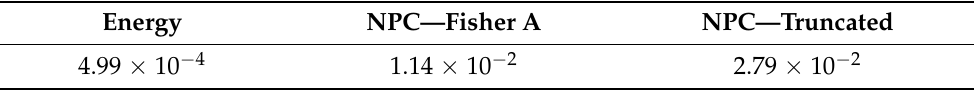
Table 6. Global p